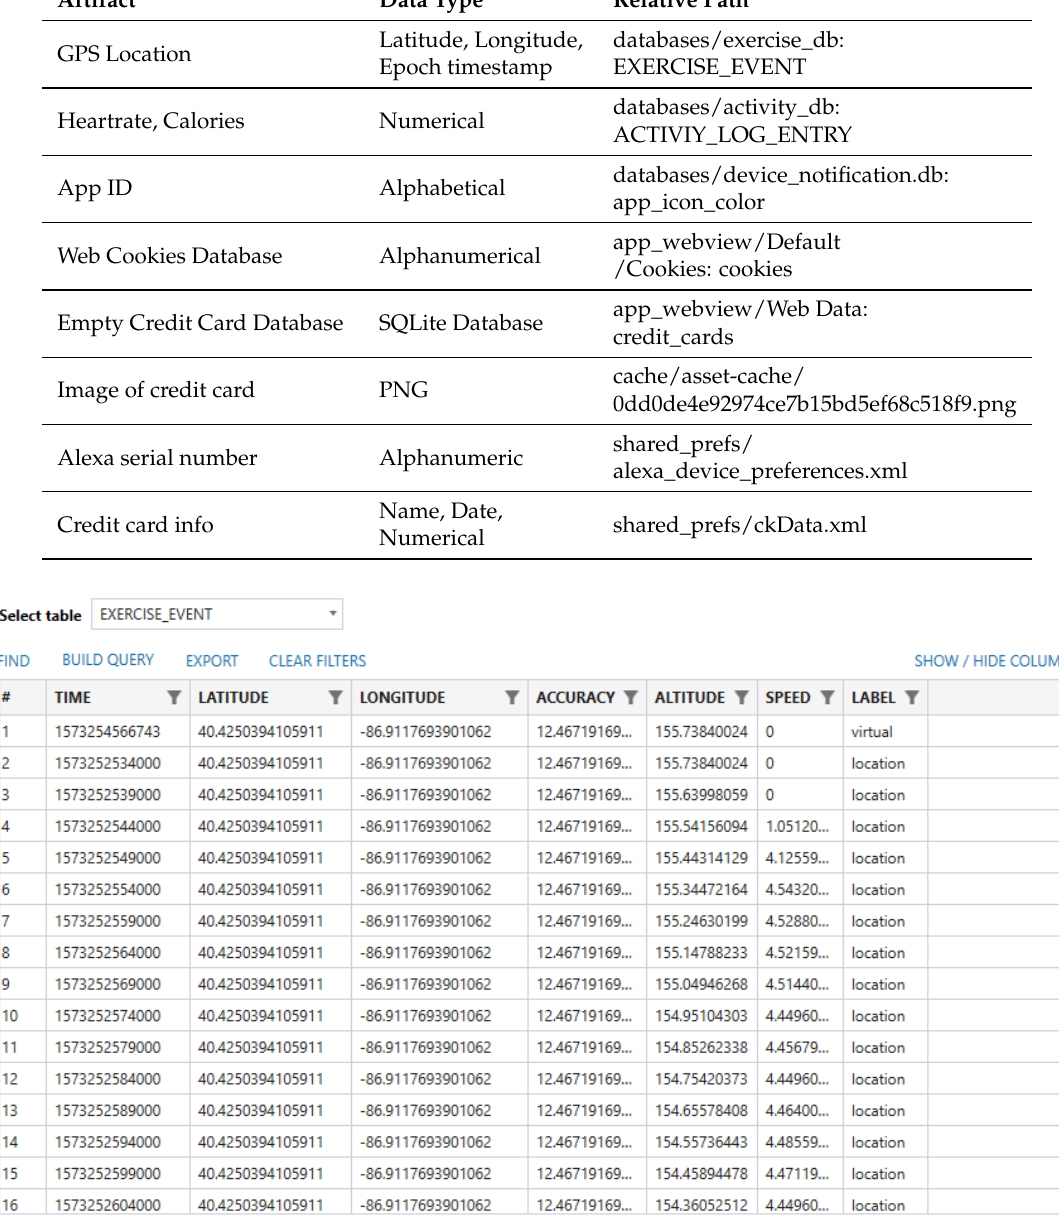
Figure 1. GPS location records found in database shown in DB Browser for SQLite. These corroborate with the routes that were used to populate exercise events. Only 16 out of 4238 rows are shown in this